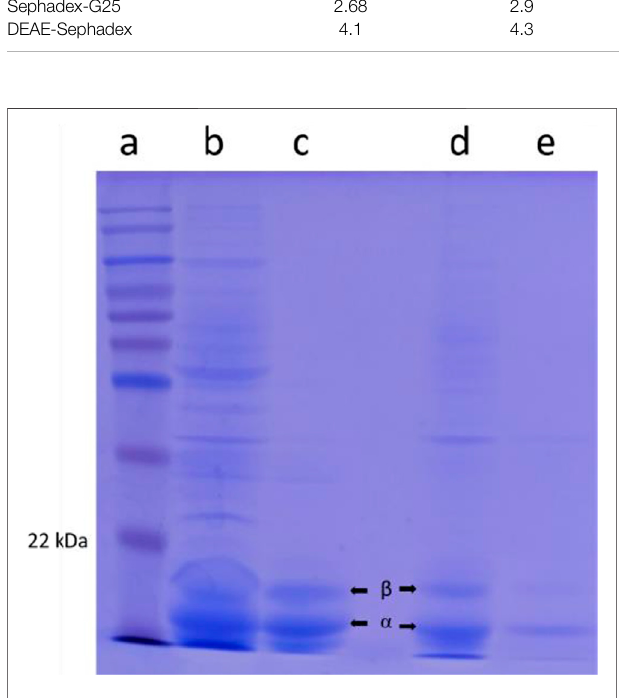
FIGURE 6 | SDS-PAGE from left to right lane. (A) Ladder. (B) Euryhalinema sp. crude cyanobacterial phycocyanin (C-PC) extract. (C) Euryhalinema sp. puri fi ed C-PC. (D) Deserti fi lum sp. crude C-PC extract. (E) Deserti fi lum sp. puri fi ed C-PC.